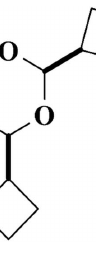
Figure 1 Synthesis of 2,4,6-tricyclobutyl-1,3,5-trioxane, 1